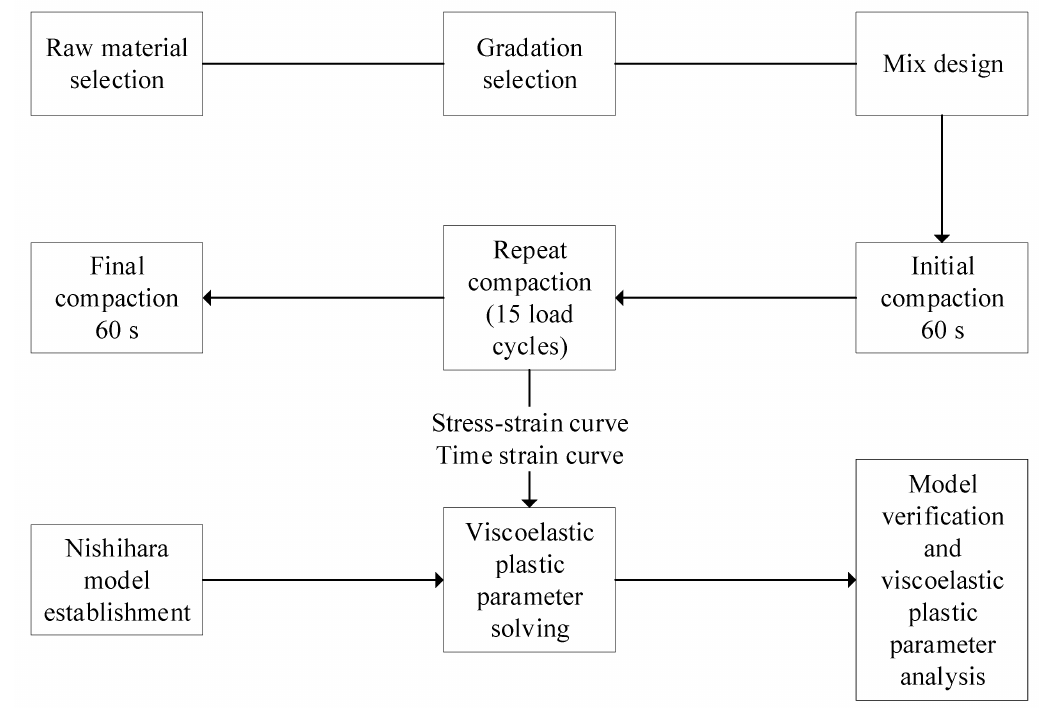
Figure 1. Flow chart of the materials and method used in this study.